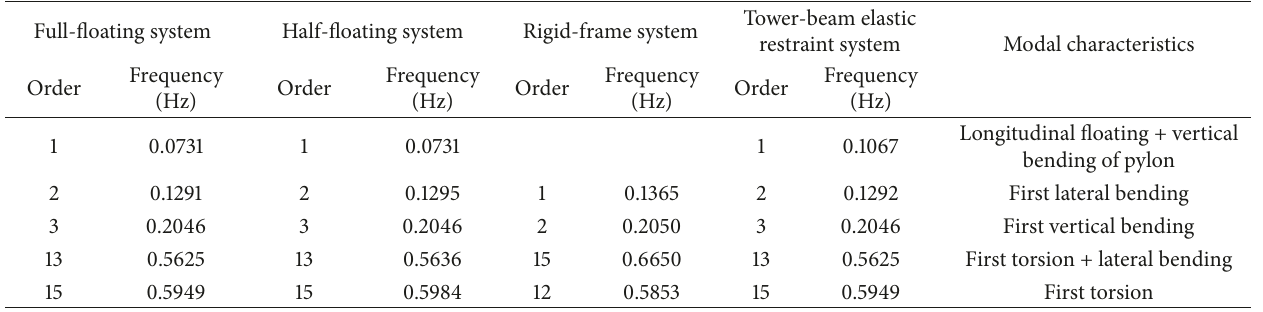
Table 6: Dynamic characteristics of CFRP cable-stayed bridge with different structural systems.